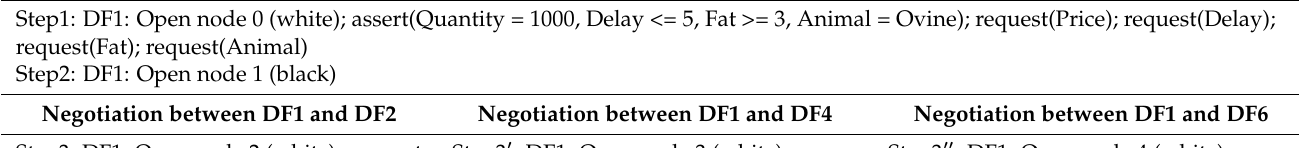
Table 4. Negotiation process description.